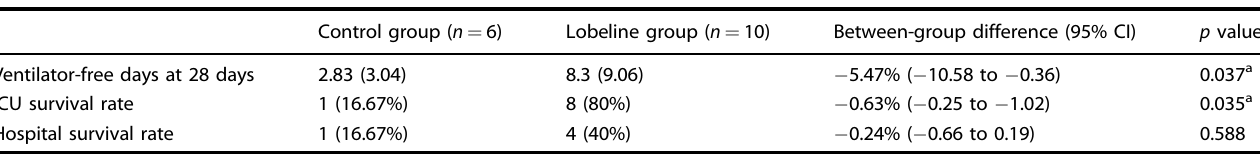
Table 2. Main clinical outcomes